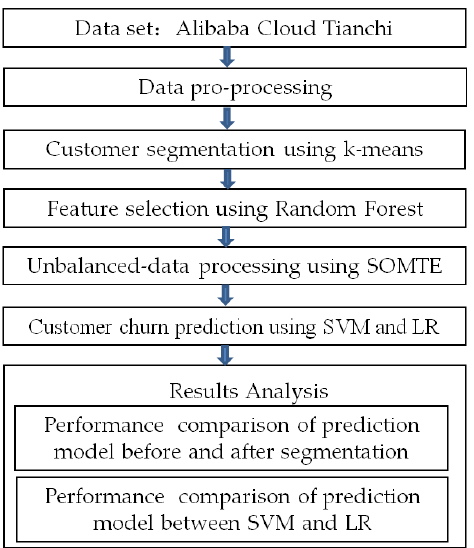
Figure 1. The process of the SVM and LR models for customer churn prediction.